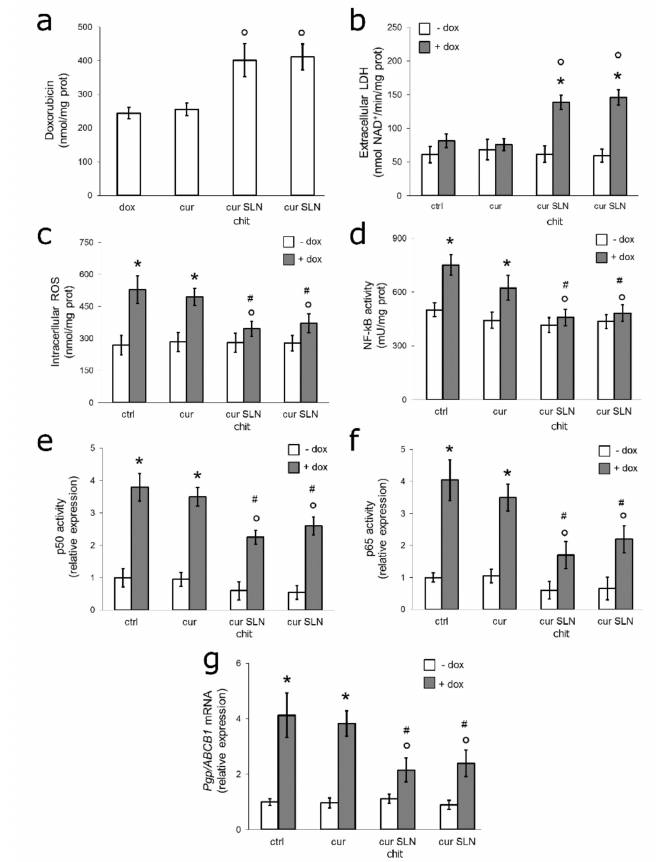
Figure 4. E ff ects of CURC-loaded SLNs against MDA-MB-231 cells co-cultured with macrophages. Human monocytic THP-1 cells, di ff erentiated into macrophages after 24 h stimulations with 500